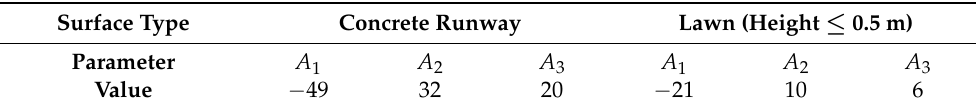
Table 1. Parameter choices of Kulemin model